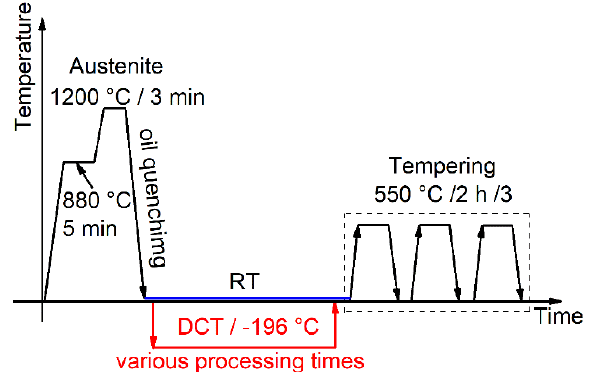
Figure 1. Schematic diagram of the heat treatment procedure. Table 2. Different heat treatments and sample codes.